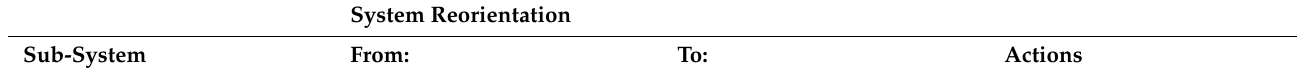
Table 1. Community-proposed interventions to promote resilient, health and food secure